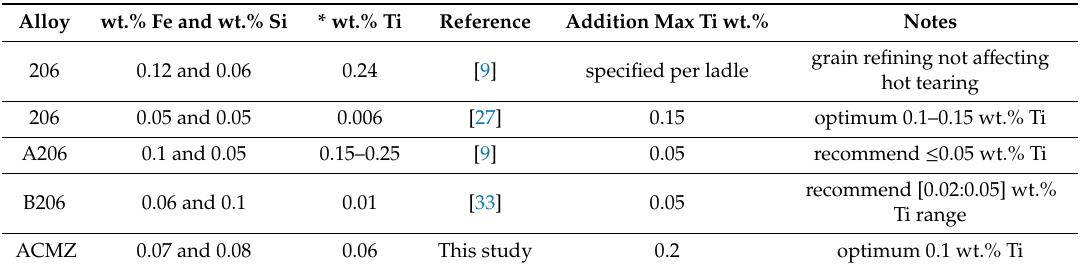
Table 6. Maximum and optimum Ti wt.% addition for hot-tearing